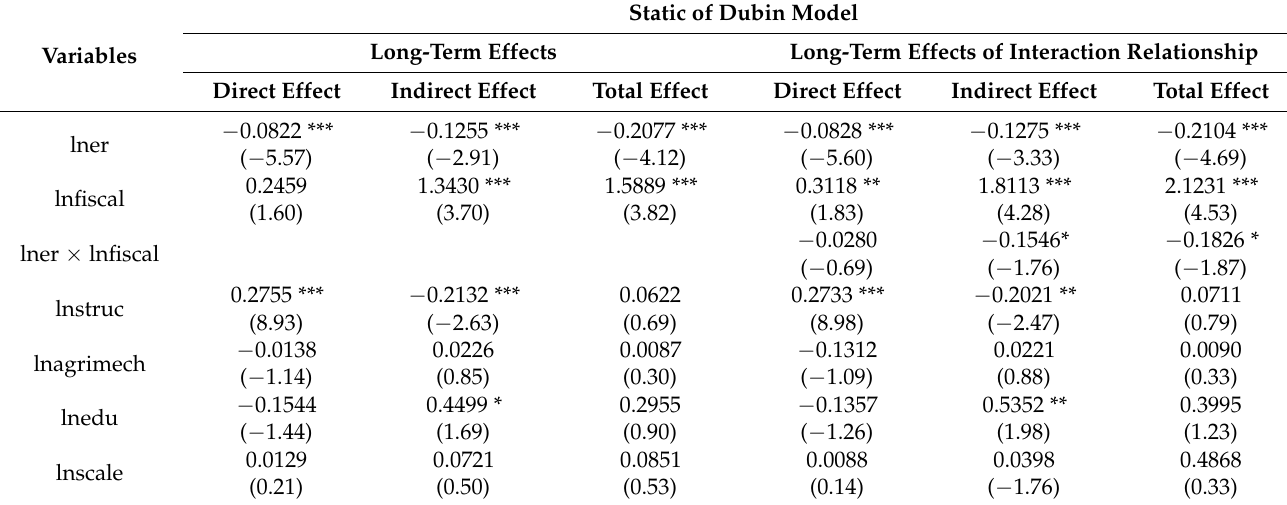
Table 5. The results of spatial Dubin model of spatial spillover